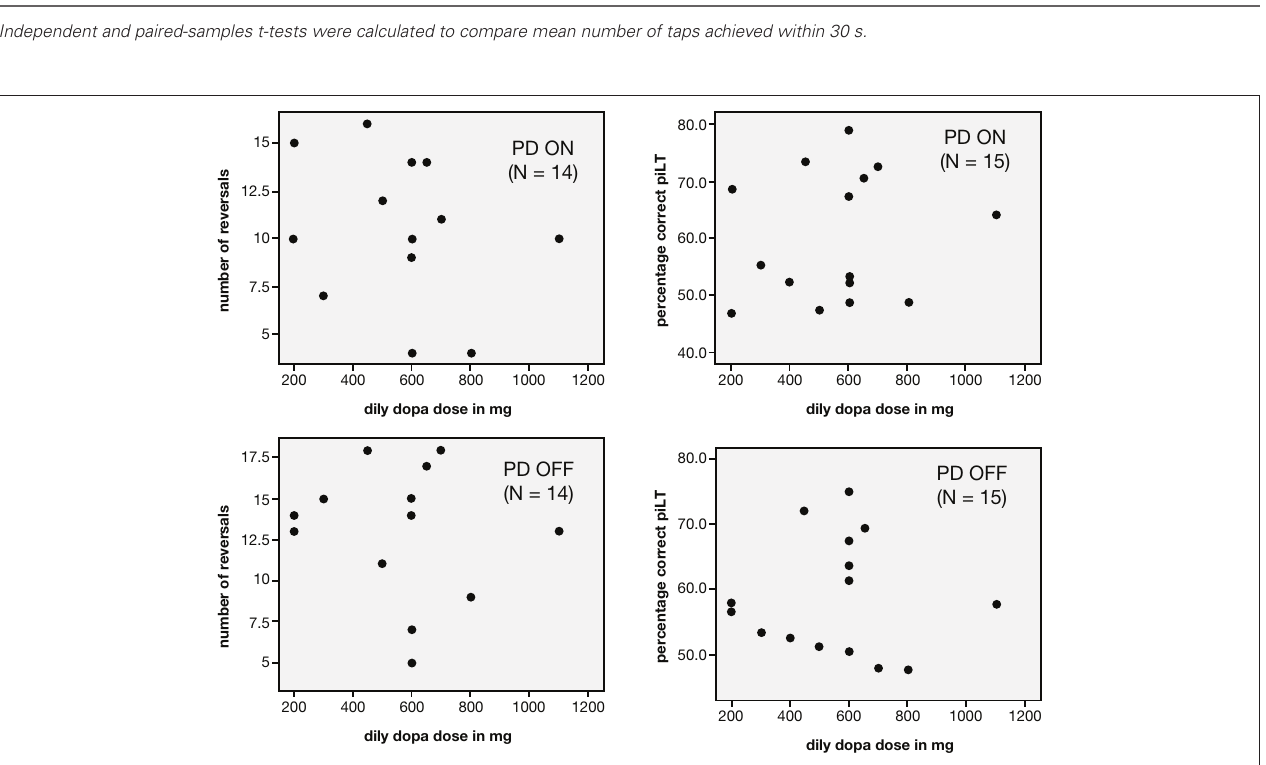
FiGure 4 | Scatterplots depicting the relationship between the daily dosage of levodopa taken by PD patients and performance measures on the reward-based learning tasks (left: number of reversals achieved in the reversal task, right: percentage correct in the learning task with constant reward